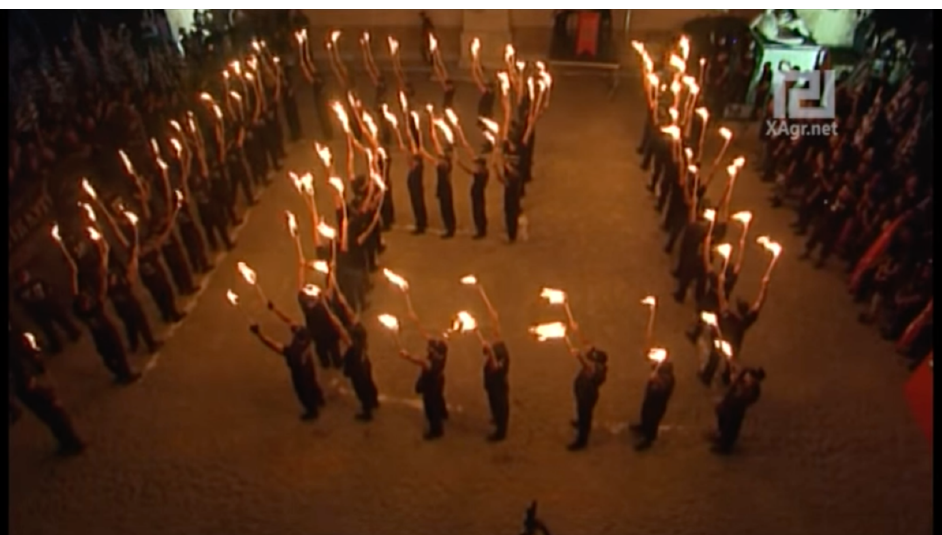
Figure 4. Commemoration event at Thermopylae organised by the Golden Dawn in 2013. [source: screenshot from YouTube video Θερμοπύλες 2013].